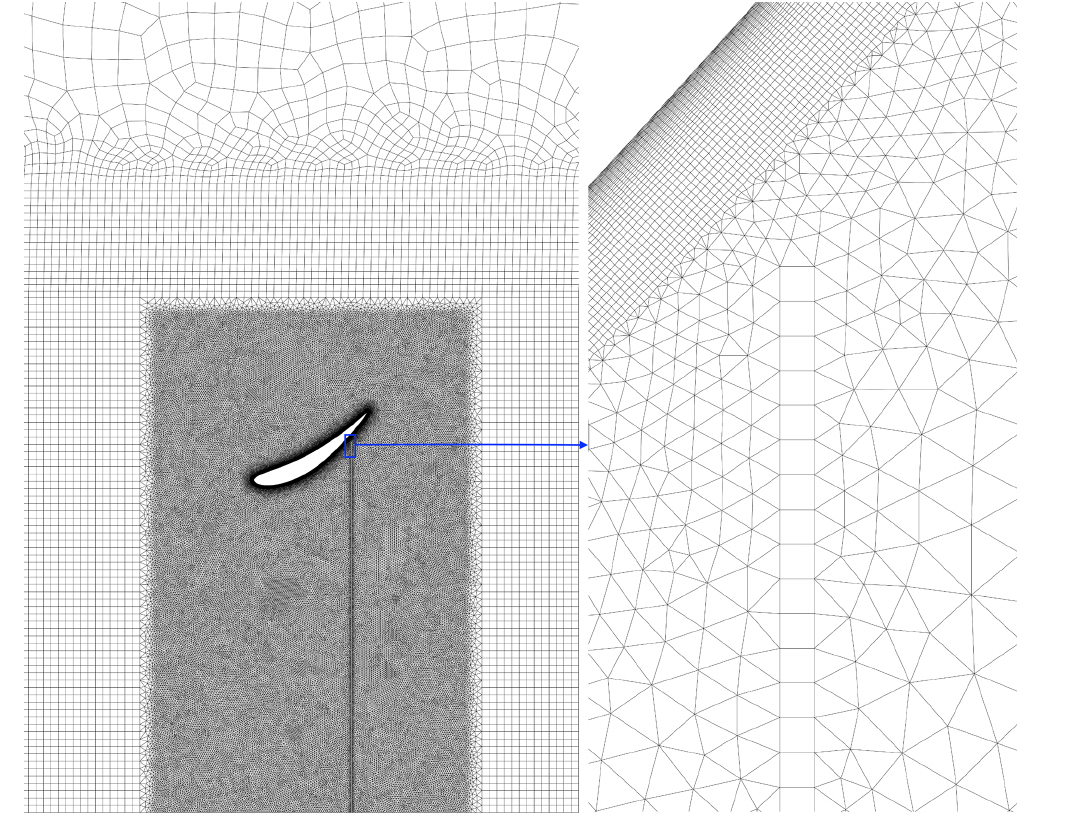
Figure 3. Grid near the duct and actuator disc.